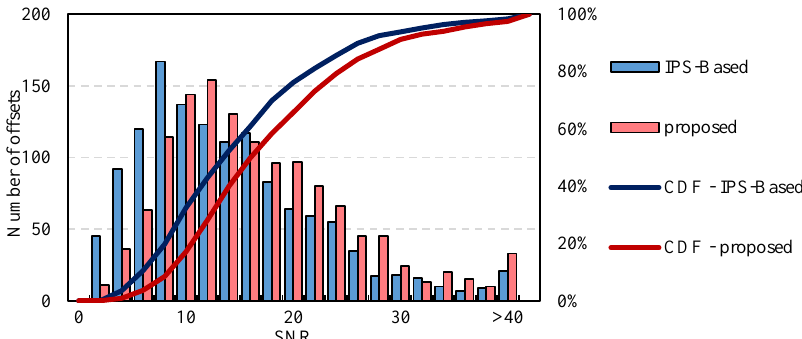
Figure 8. Histogram and cumulative distribution function (CDF) of signal-to-noise ratios (SNR)